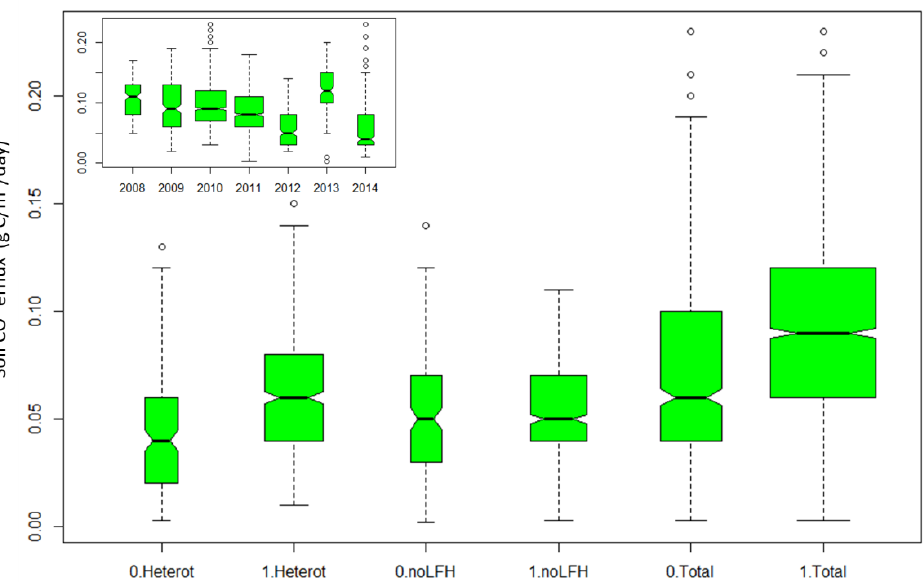
Figure 5. Comparison of mean daily soil CO 2 effluxes measured (1) pre- and (0) post-harvesting for total soil CO 2 efflux (Total), heterotrophic efflux (Heterot), and mineral-soil horizon efflux (noLFH).